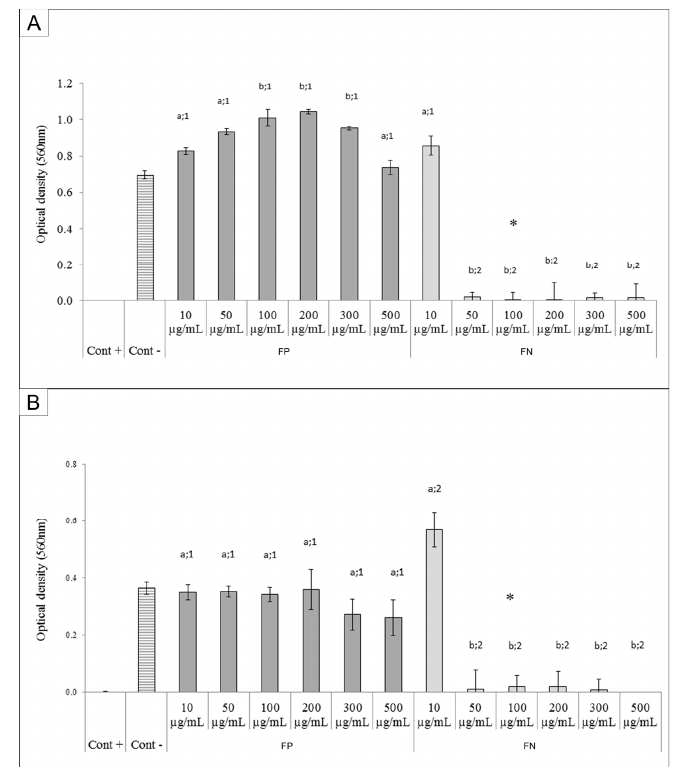
Figure 8. Minimum inhibitory concentration (MIC) activity and minimum bactericidal concentration (MBC) of FP from D. mertensii and FN for E. coli ( A ) and S. aureus ( B ). The samples were incubated at different concentrations (10, 50, 100, 200, 300, and 500 µ g/mL). *—minimum bactericidal concentration; Cont. +, positive control (medium, bacterium, and antibiotic); Cont. − , negative control (medium and bacterium). Different letters (a,b) represent the significant difference between FP and FN at different concentrations; different numbers (1,2) represent the significant difference between FP and FN at the same concentration by ANOVA followed by Newman-Keuls test ( p <